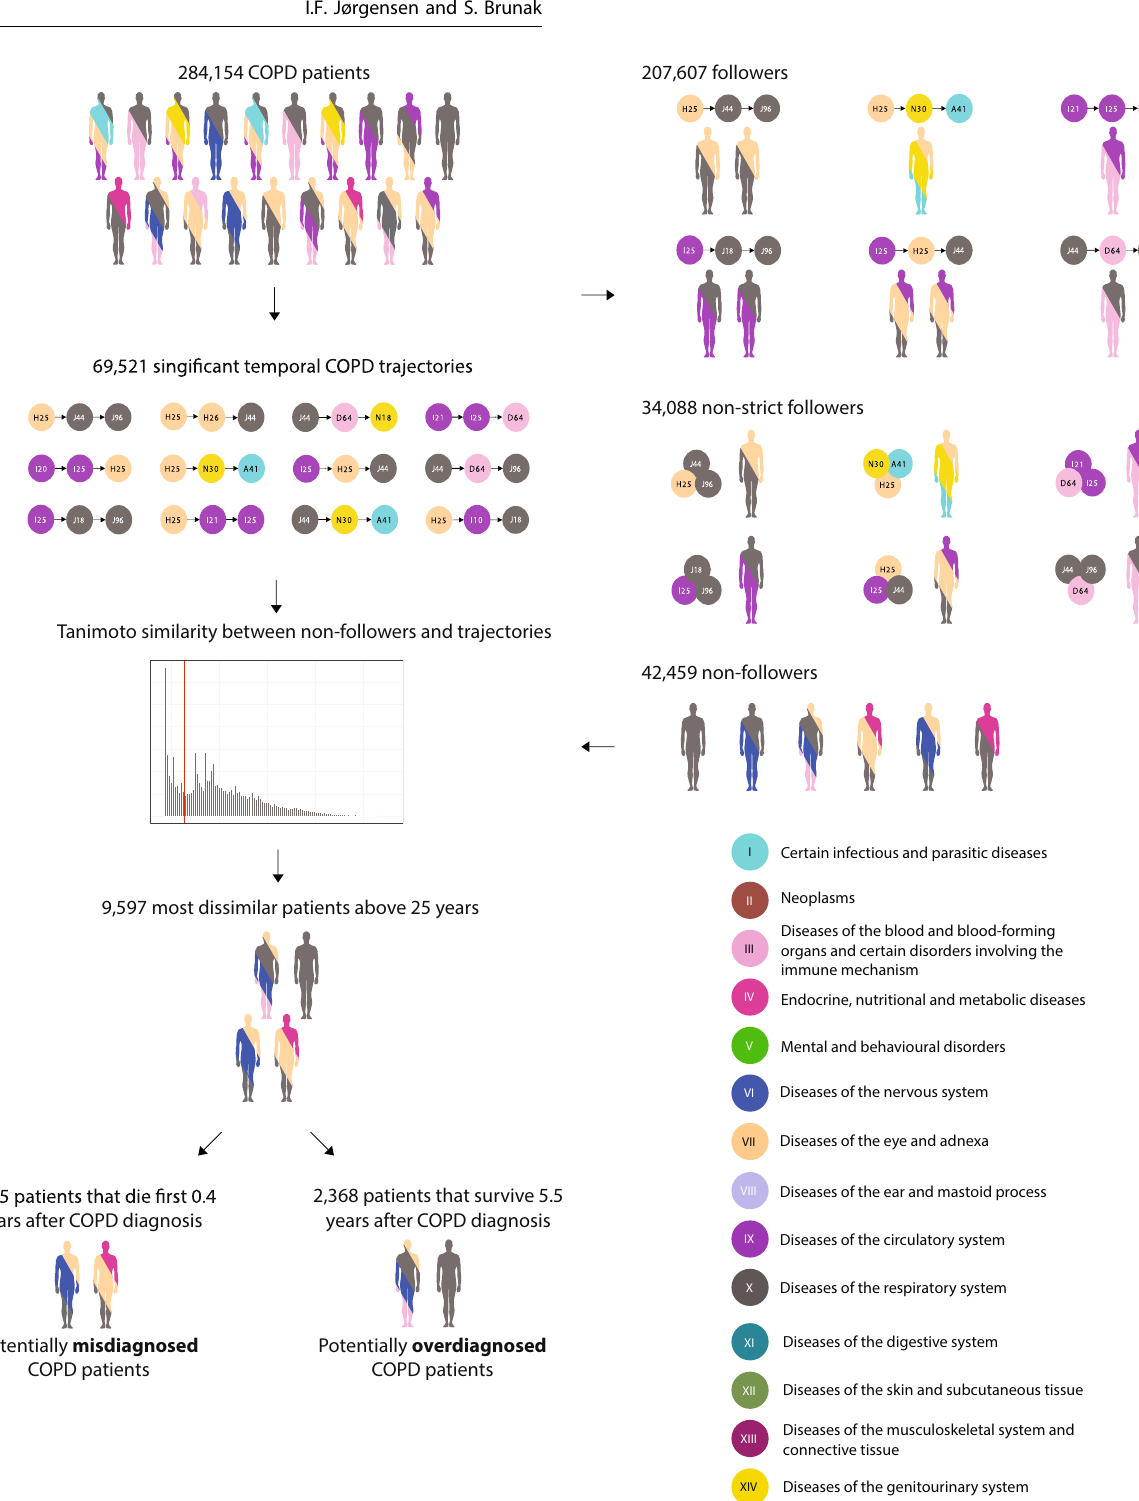
Fig. 1 Work fl ow. In all, 284,154 patients with chronic obstructive pulmonary disease (COPD) were identi fi ed in the Danish National Patient Registry. These patients displayed 61,521 signi fi cant temporal disease trajectories with three consecutive diseases. The far majority (207,607) of the patients followed at least one of these trajectories in chronological order, whereas 34,088 followed at least one of the trajectories in a non-chronological order. Thus, 42,459 COPD patients do not follow any of the common COPD trajectories and their COPD appear without the most common comorbidity context. The individual patient history of these non-followers was compared with all COPD trajectories using an adjusted Tanimoto similarity score, showing a subset of 9597 COPD patients that present with a very different disease pro fi le compared with the general COPD patient. This group of patients show very different patterns of survival after the COPD diagnosis, where 2185 patients die early (within the fi rst 0.4 years) after COPD diagnosis and are hypothesised to be at risk of misdiagnosed COPD. The other group survives for longer than 5.5 years after COPD diagnosis and could be potentially at risk of